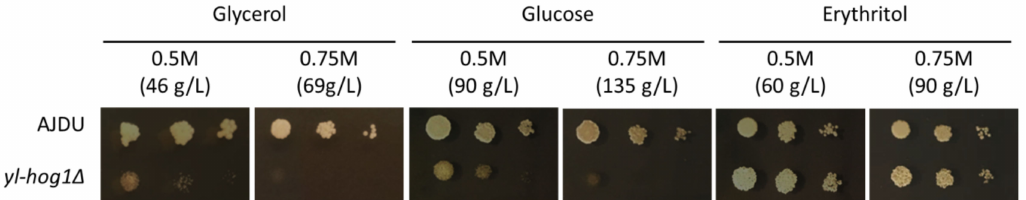
Figure 2. Growth of Y. lipolytica AJDU and yl-hog1 ∆ after 48 h of incubation on YNB agar plates with di ff erent carbon